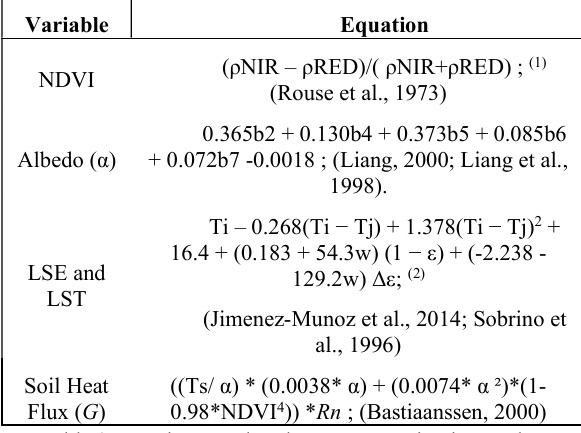
Table 2.Equations used to the pre-processing image